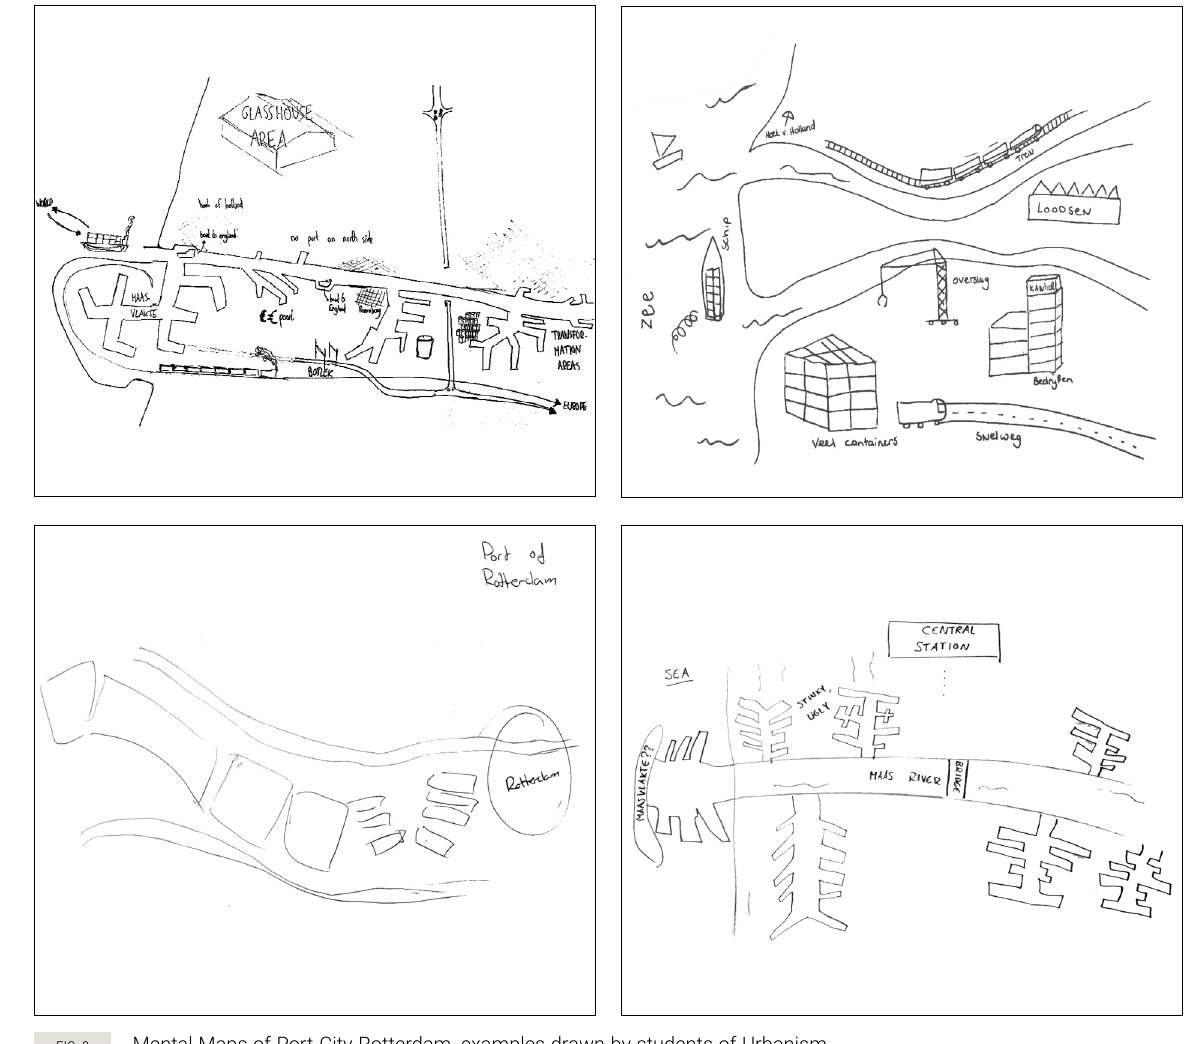
FIG. 3 Mental Maps of Port-City Rotterdam, examples drawn by students of Urbanism (a), Transport, Infrastructure and Logistics (c), Architecture (b), and Media Studies (d), 2020, credits trough anonymized responses in the graduate course on People, Movement and Public Space by Maurice